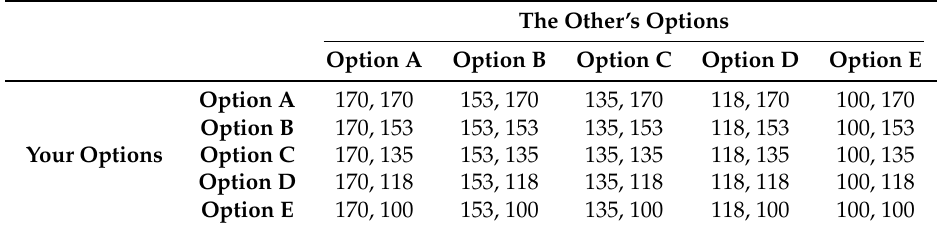
Table A2. Recomposition of task number one into a matrix game.